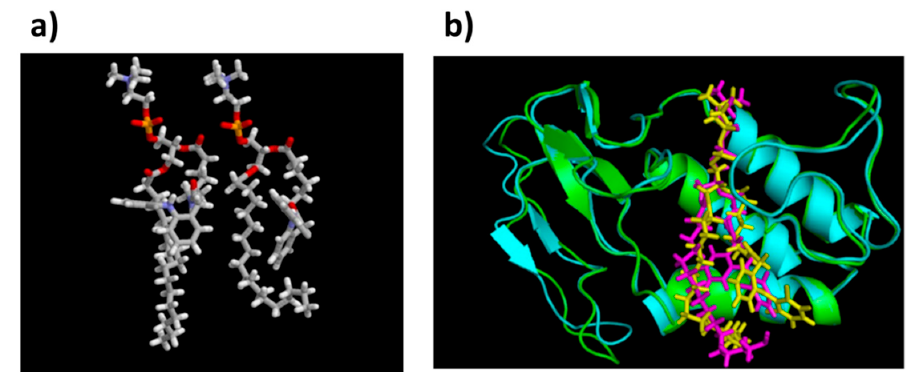
Figure 4. ( a ) Optimized transition state geometries of PL-diclofenac prodrugs with 5 vs. 6 carbons linker, Figure 4. (a) Optimized transition state geometries of PL ‐ diclofenac prodrugs with 5 vs. 6 carbons within human PLA 2 (the protein structure was removed for simplicity); ( b ) Equilibrated structures of linker, within human PLA 2 (the protein structure was removed for simplicity); (b) Equilibrated PL-diclofenac conjugates with linker lengths of 2- and 6- CH 2 units in bee venom PLA 2 . Figure 4b is structures of PL ‐ diclofenac conjugates with linker lengths of 2 ‐ and 6 ‐ CH 2 units in bee venom PLA 2 . reproduced with permission from Figure 4b is reproduced with permission from [25].